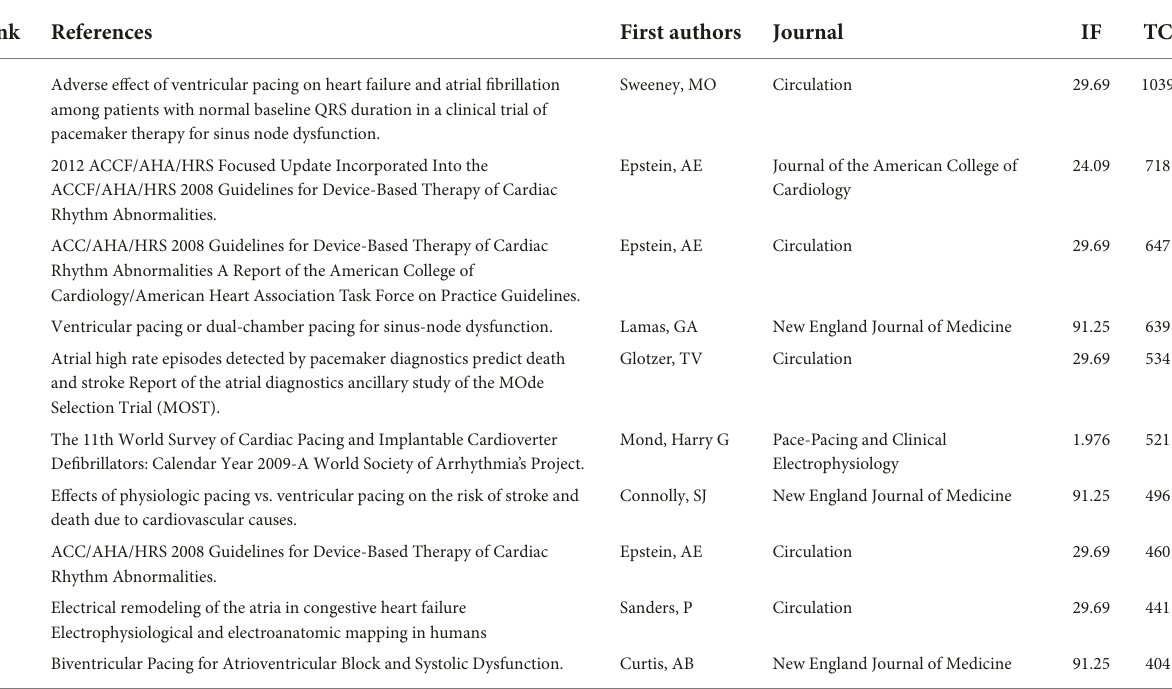
TABLE 5 The top 10 references of sick sinus